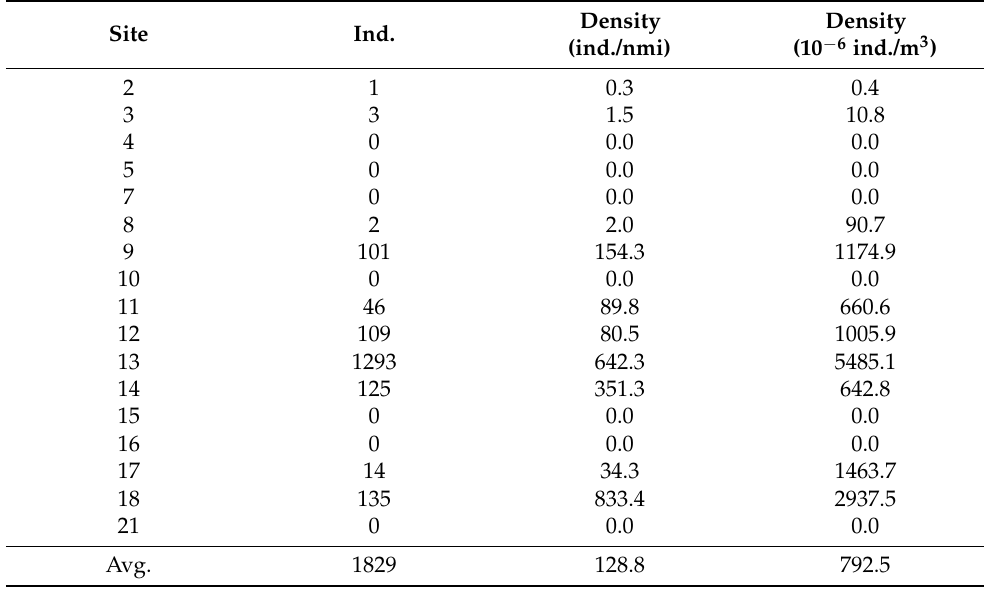
Table 4. Distribution density of jellyfish using the trawl survey method in the East China Sea. Site Ind.